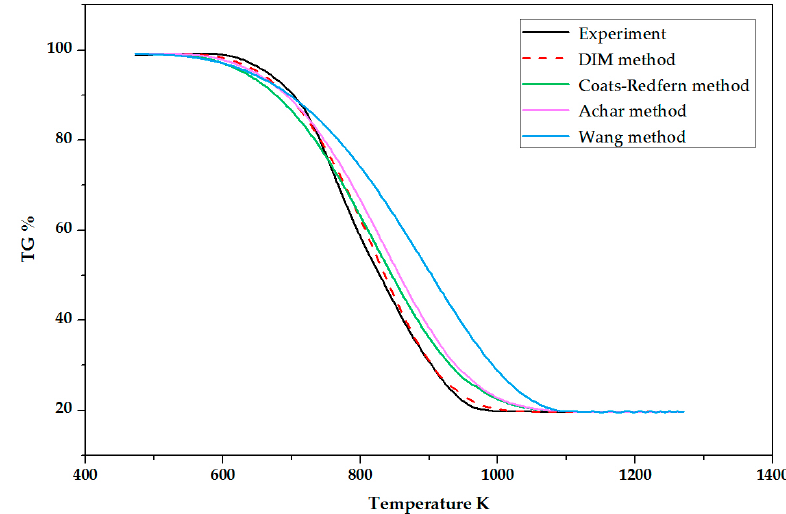
Figure 3. The four kinds of calculated curves (DIM, Wang, Achar, and Coats-Redfern methods) and experimental TG curve at a 7% O 2 concentration.